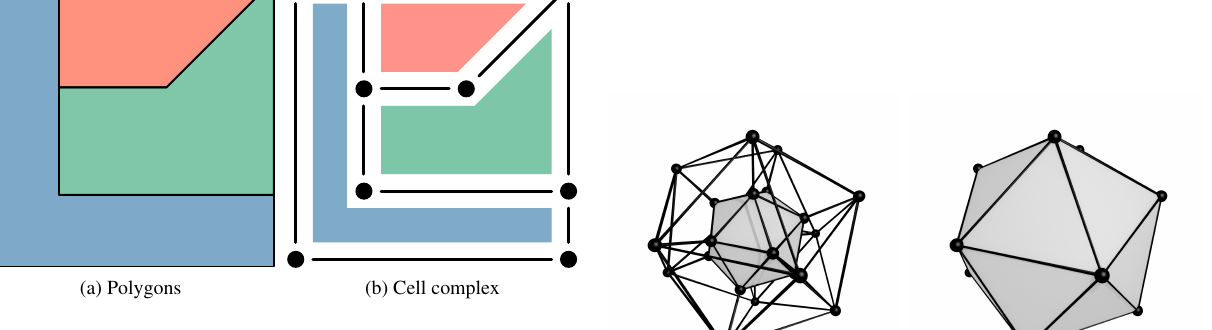
Figure 1: (a) A set of polygons can be represented as (b) a 2D cell complex consisting of 0-cells (black disks), 1-cells (black lines), and 2-cells (coloured polygons).